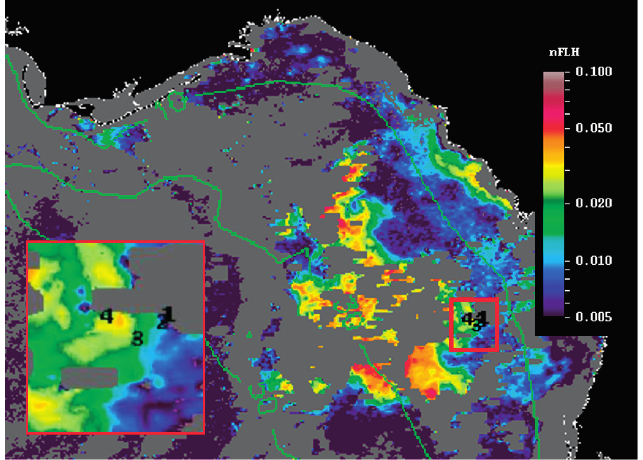
Figure 6. MODISA nFLH image on 23 July 2014 (19:05 GMT) showing an extensive bloom patch of about 7000 km 2 . The corresponding VIIRS ERGB image from an adjacent day (18 July 2014) is shown in Figure 2d. Around the east edge of the bloom 4 stations are annotated (red box, inset figure). The high nFLH values along the coast are likely due to sediment resuspension. Vertical profiles of ocean properties at the four stations, along with K. brevis concentrations in surface waters, are shown in Figure